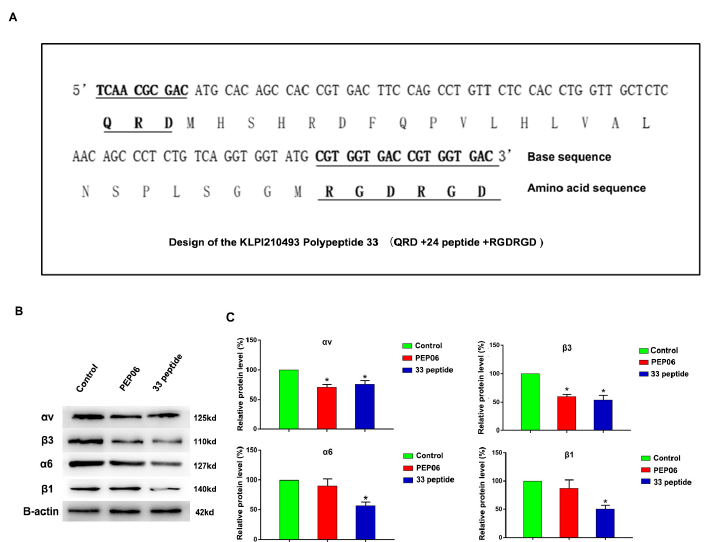
Figure 1. ( A ): Structure of endostatin 33 peptide (QRD (glutamine-arginine-aspartic acid) sequence + 24 peptide + RGDRGD (arginine–glycine–aspartic acid–arginine–glycine–aspartic acid) sequence). ( B , C ): Western blot was used to detect the protein expression of α v β 3 and α 6 β 1 in the 33 polypeptide group, PEP06 group and 5% glucose solution group. (* stands for p value < 0.05)